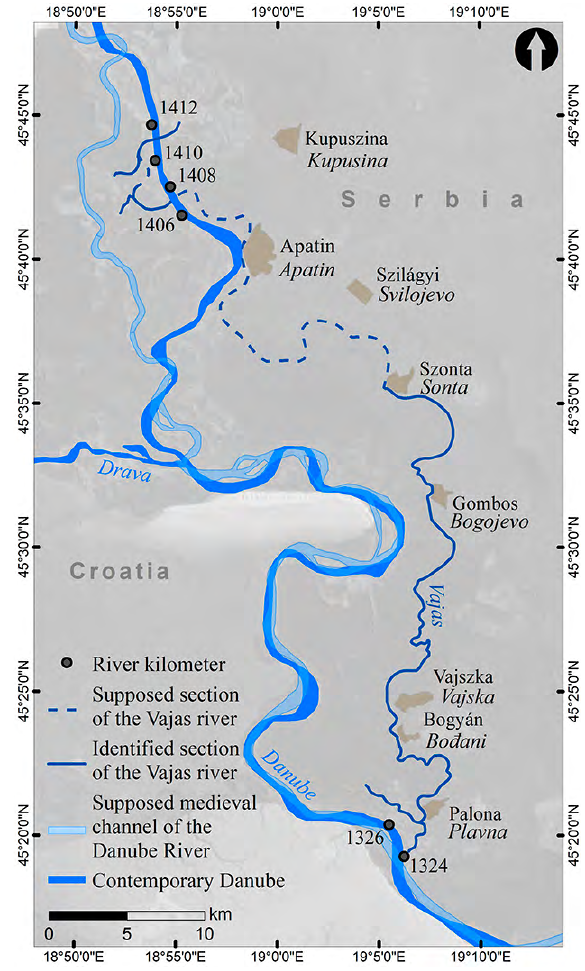
Figure 5. The reconstructed channel of the Vajas